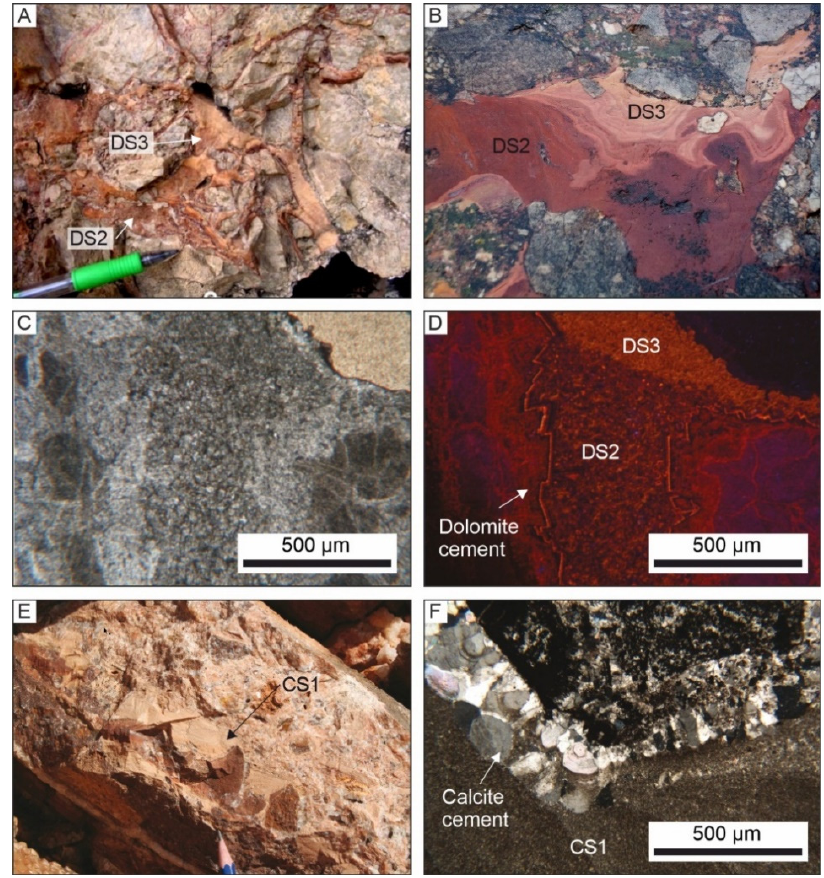
Figure 7. Main features of host dolostones RD1 and DS2, DS3 and CS1 karst fill in the Castellví outcrop ( C , D photographs are from [3]). ( A ) Field photograph of DS2 and DS3 within fractures in RD1. ( B ) Field photograph of DS2 and DS3 filling a karst cavity within RD1. ( C , D ) Optical (plane polarised light) and CL images of the relationships between DS2, DS3 and dolomite cement. ( E ) Field photograph of CS1 bounding fragments of RD1. ( F ) Photomicrograph of CS1 bounded by calcite cement in contact with RD1 fragment (cross polarised